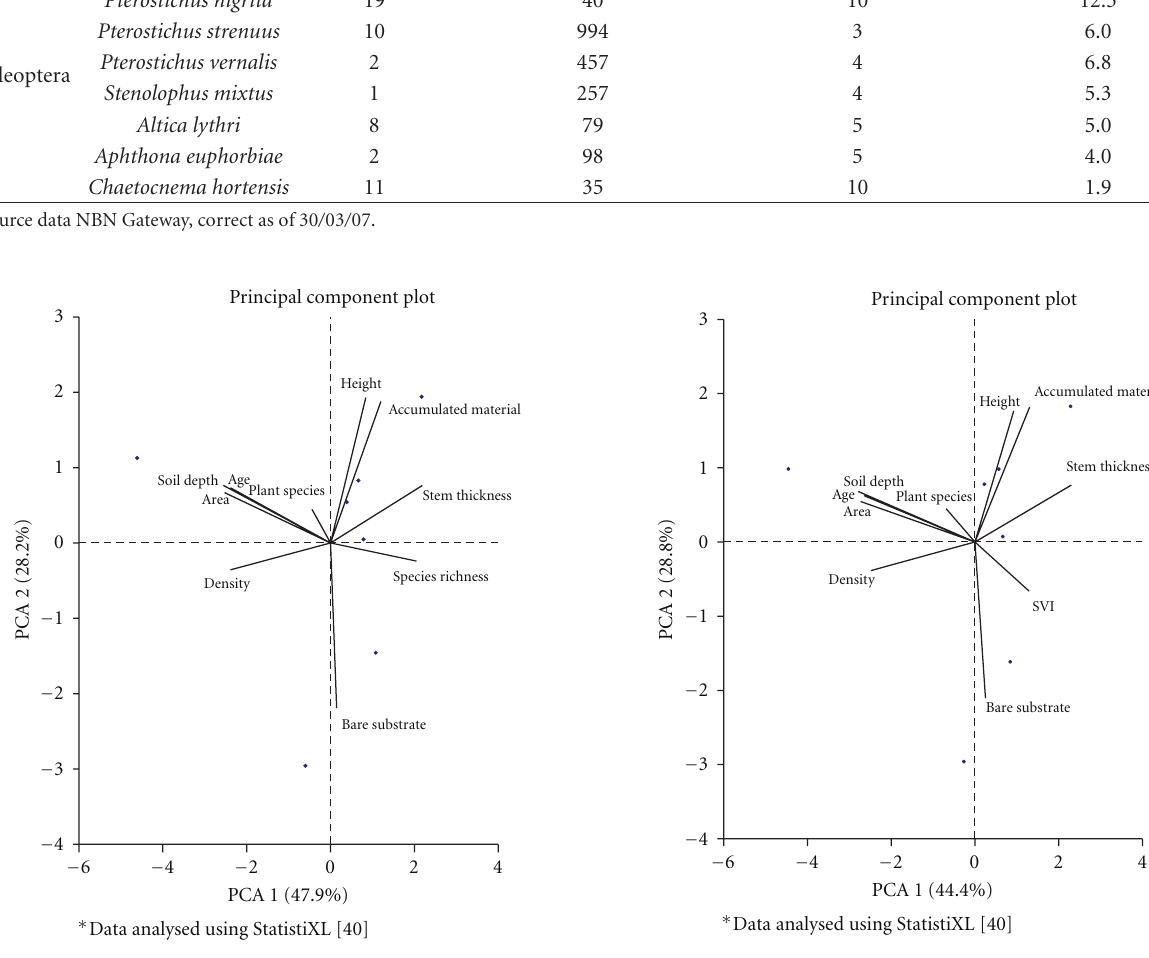
Figure 5: PCA ∗ of SCVI against all other Site-Specific Variables. From the PCA Analysis of Species Value Index of invertebrates across all reed-bed sites, only bare substrate was found to be positively correlated, whilst age, area, soil depth, and plant species richness were found to be negatively correlated. All other variables measured did not a ff ect species